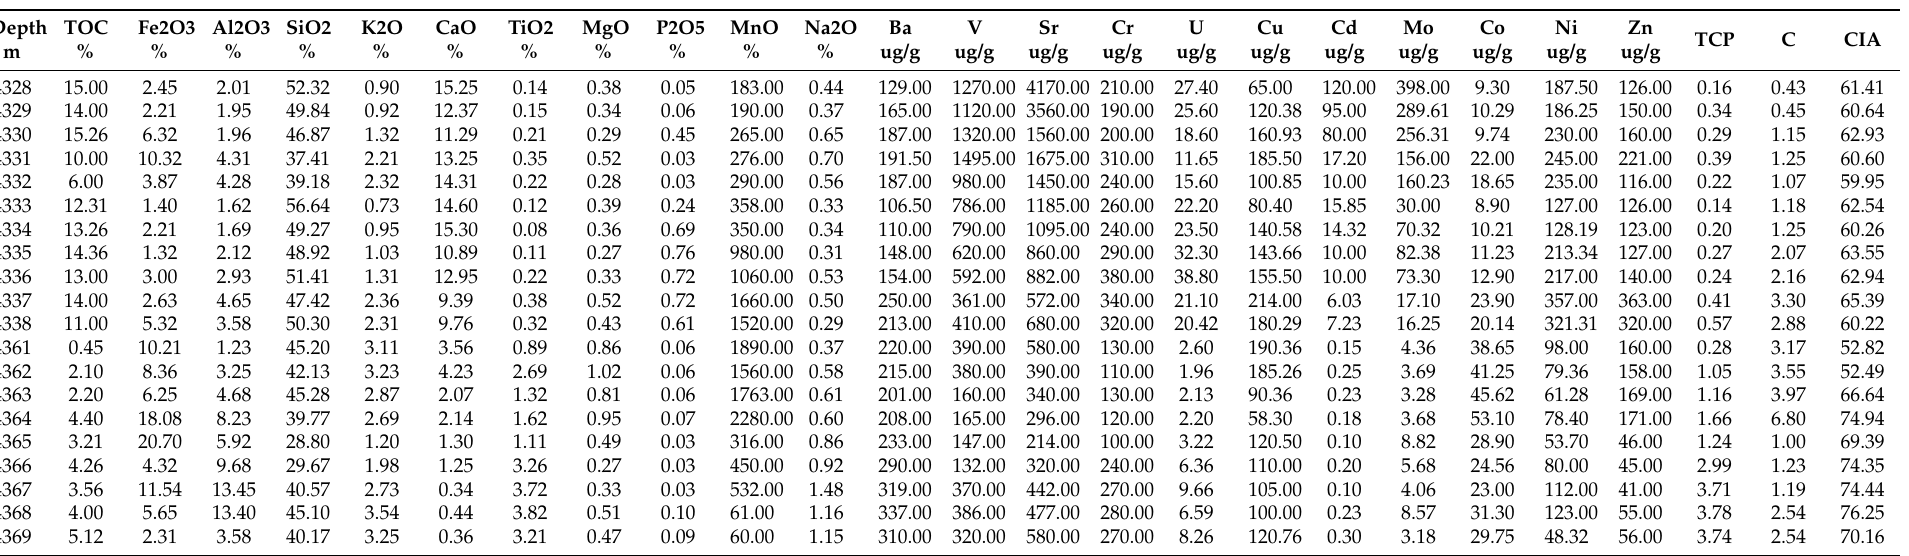
Table 1. TOC, major, and trace element contents and their correlation values of the shales of the Wujiaping